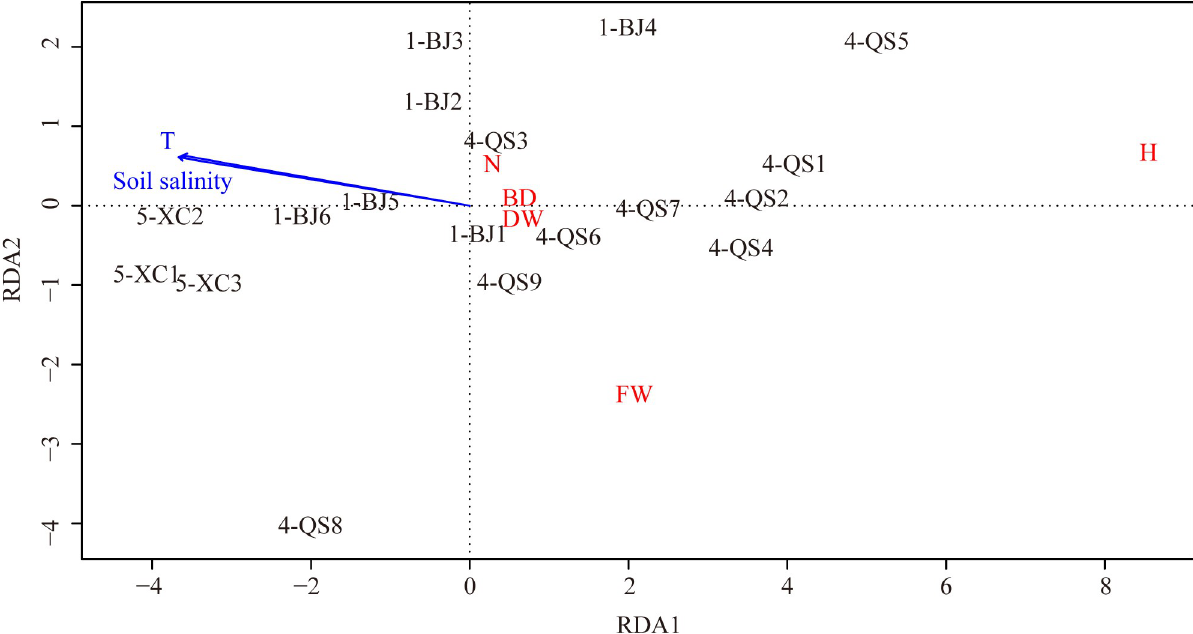
Fig 5. Ordination diagram of redundancy analysis (RDA) with quadrats, phenotypic traits, and environmental variables (arrows) of population 1-BJ, 4-QS, and 5-XC. FW: the average fresh weight per plant; DW: the average dry weight per plant, H: the average height; BD: the average basal diameter; N: the average number of nodes of a stem; T: the average annual mean